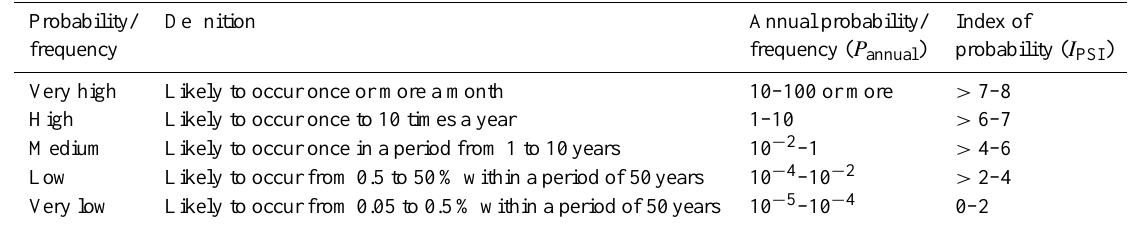
Table C1. Classification of probability of ship incidents and correspondence between annual probability and index of probability (obtained from Filipe and Pratas, 2007, and inspired by IMO recommendation – IMO,